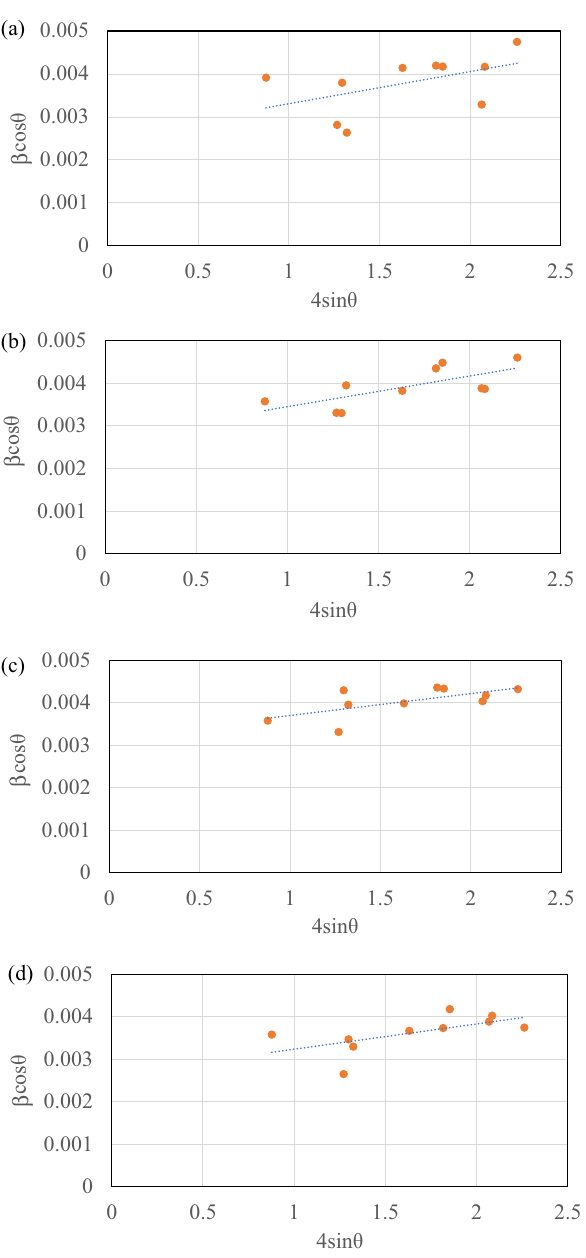
Fig. 3 Williamson-Hall plots of TiO CaCO (X g) catalysts; X = a 0, b 0.4, c 0.8, and d 4.0 g 3